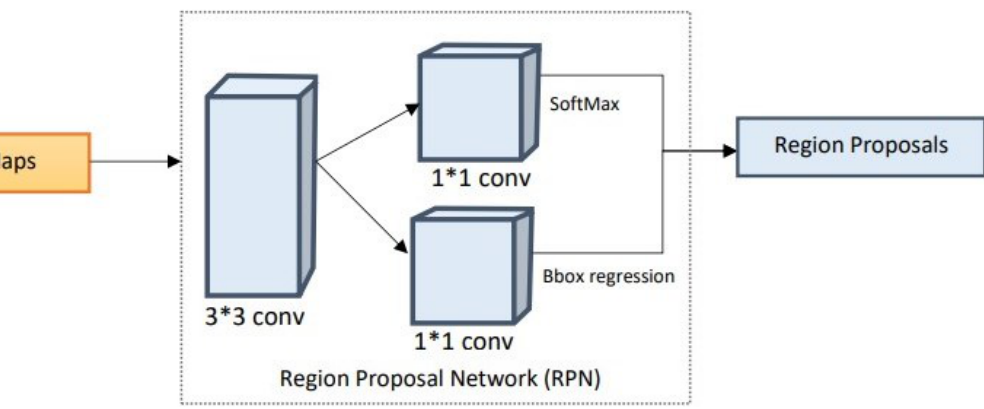
Figure 6. Structural diagram of the region proposal